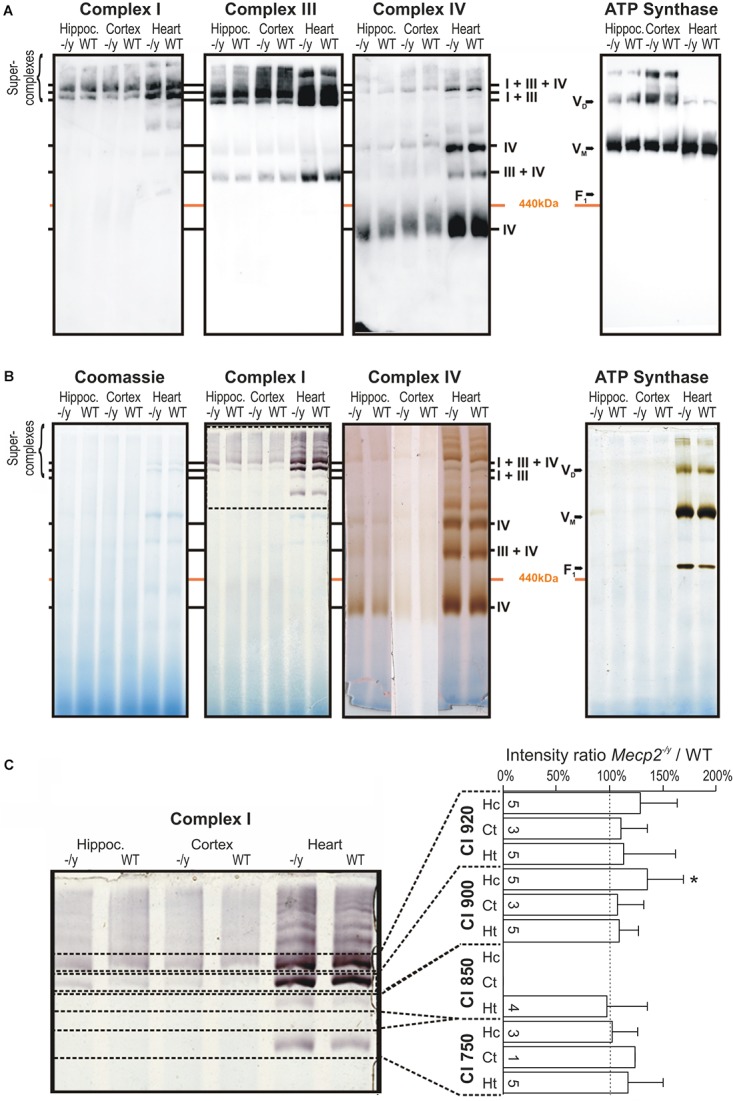
Pathological remodeling of the respiratory chain supercomplexes in mitochondria of Mecp2-/y mice is not evident. (A) Isolated mitochondria were solubilized in digitonin, separated by native gel electrophoresis (BN-PAGE), and respiratory chain complexes were analyzed by Western blotting. Due to limited space, Mecp2-/y tissue is denoted here as “-/y”. (B) Respiratory chain complexes were separated by BN-PAGE and stained for enzymatic activity of CI, CIV, and CV. Marked alterations for the respective respiratory complexes were not found. The section of the gel flanked by the dashed lines was analyzed in more detail in panel C. (C) Quantitative analysis of CI activity staining by densitometry does not reveal marked genotypic differences among WT and Mecp2-/y hippocampus. Dashed line indicates WT conditions, the number of samples (mice) analyzed is indicated (∗p > 0.05, one sample t-test).